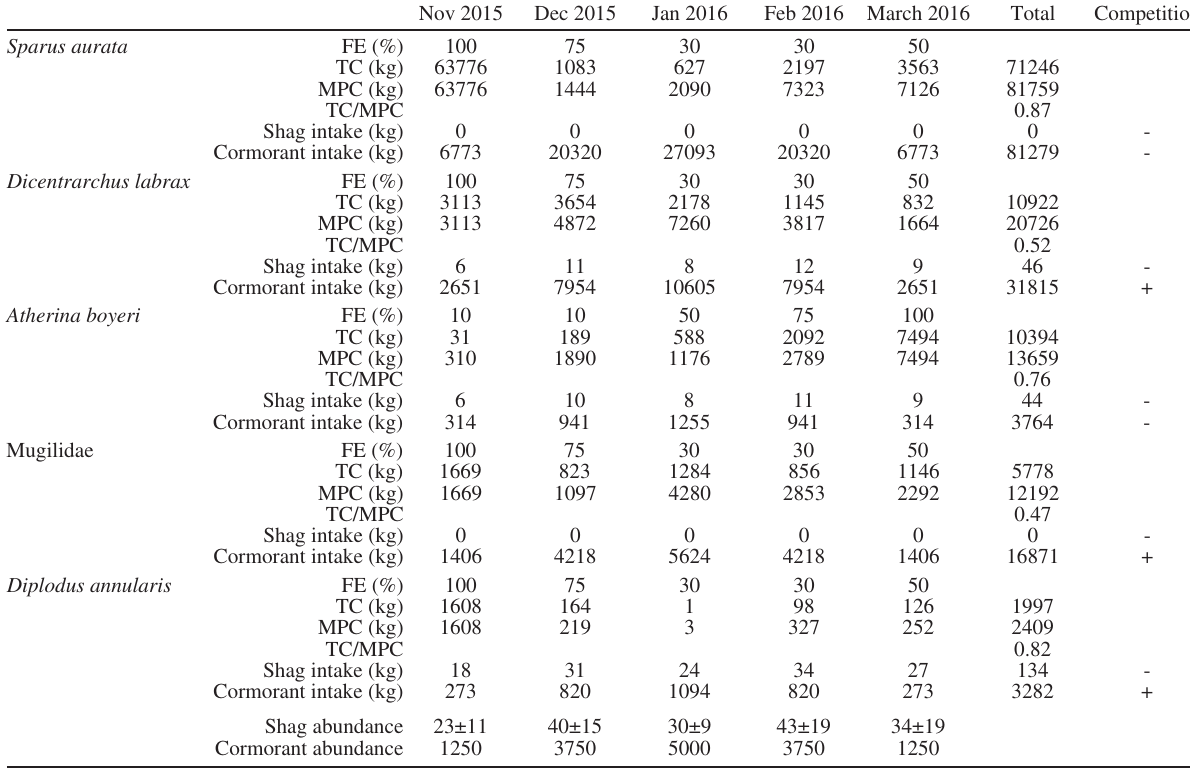
Table 5. – Monthly fishing effort (FE), total catch (TC) and maximum potential catches (MPC) of high commercial interest fish species by FASP fishermen, and estimated monthly shag and great cormorant intake. Abundance of shag and great cormorant during 2016 breeding-